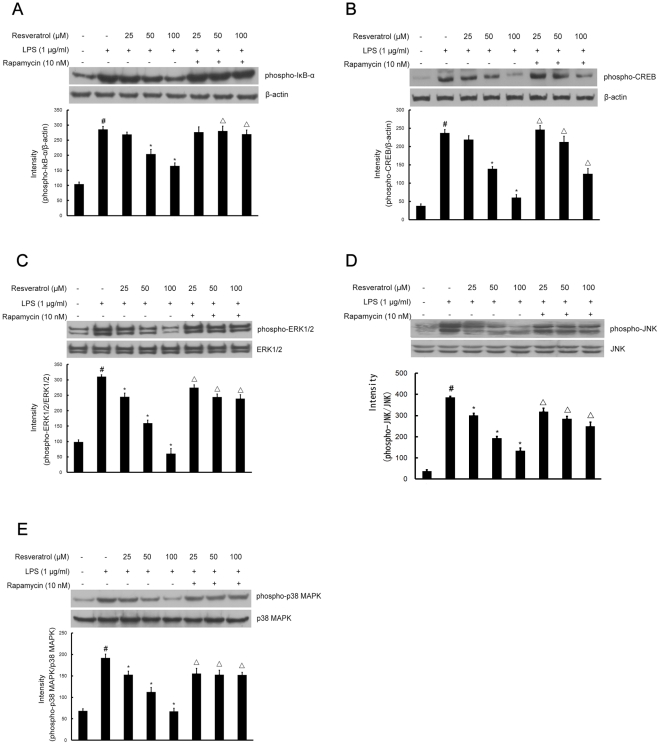
Inhibition of phosphorylation of IκB-α, CREB, and MAPKs signaling by resveratrol is mTOR-dependent during BV-2 cells activation by LPS.Approximately 1×106 cells/ml were seeded in six-well plates and incubated until 80% confluency. Cells were pre-treated with resveratrol (25, 50, and 100 µM) for 1 h in the absence or presence of rapamycin (10 nM), then exposed to LPS (1 µg/ml) for 30 min. Cell lysates (50 µg protein) were prepared and subjected to Western blot analysis by using antibodies specific for phosphorylated forms of IκB-α, CREB, ERK1/2, JNK and p38 MAPK (shown as phospho-IκB-α, etc.) as described in the methods. Equivalent loading of cell lysates was determined by reprobing the blots with anti-β-actin, total ERK1/2, JNK or p38 MAPK antibodies. The relative protein levels were quantified by scanning densitometry and normalized to β-actin, total ERK1/2, JNK or p38 MAPK. The values shown are mean ± SEM of data from three independent experiments. #Significant compared with control alone, p<0.05. *Significant compared with LPS alone, p<0.05. ▵Significant compared with resveratrol+LPS, p<0.05.